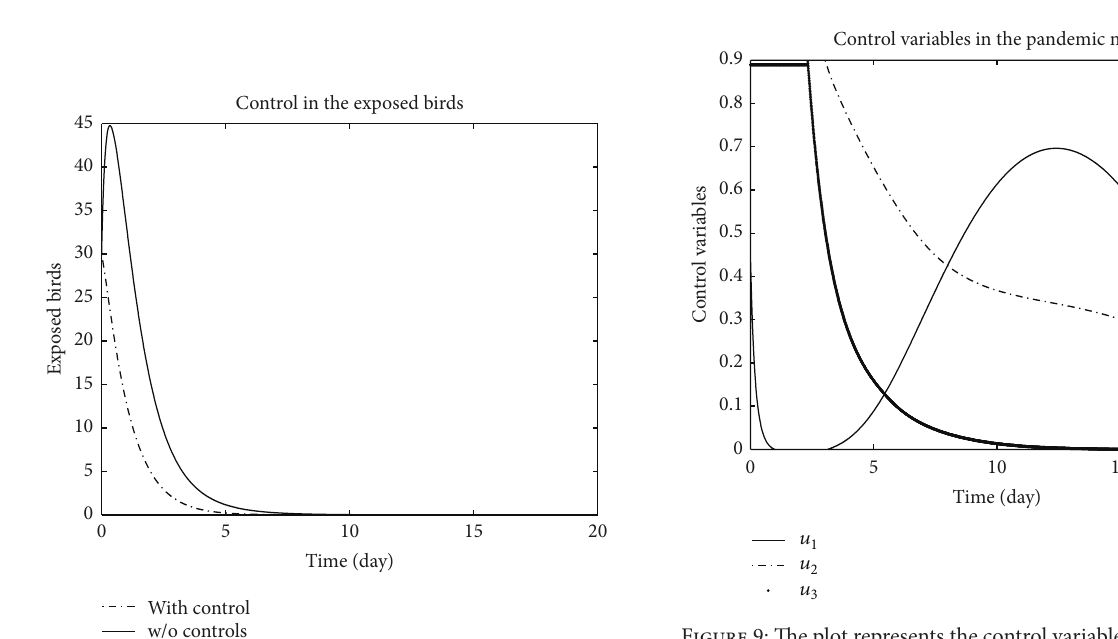
Figure 9: The plot represents the control variables 𝑢 1 , 𝑢 2 , and 𝑢 3